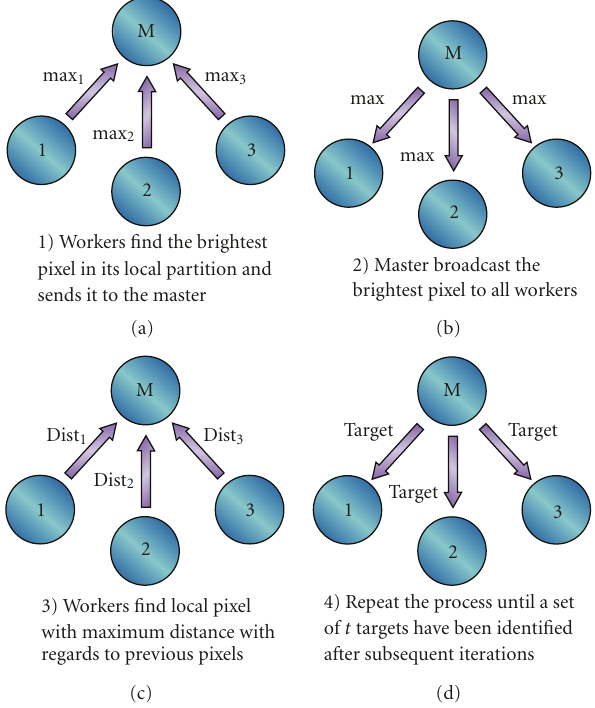
Figure 4: Graphical summary of the parallel implementation of ATDCA algorithm using 1 master processor and 3